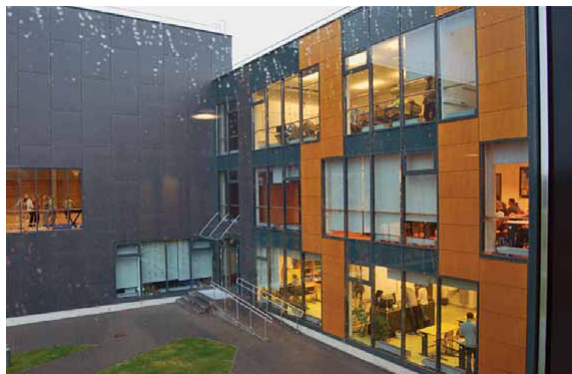
fig. 6. The realization of the partnership project on the school in Balsiai, Vilnius at the local authority level: the